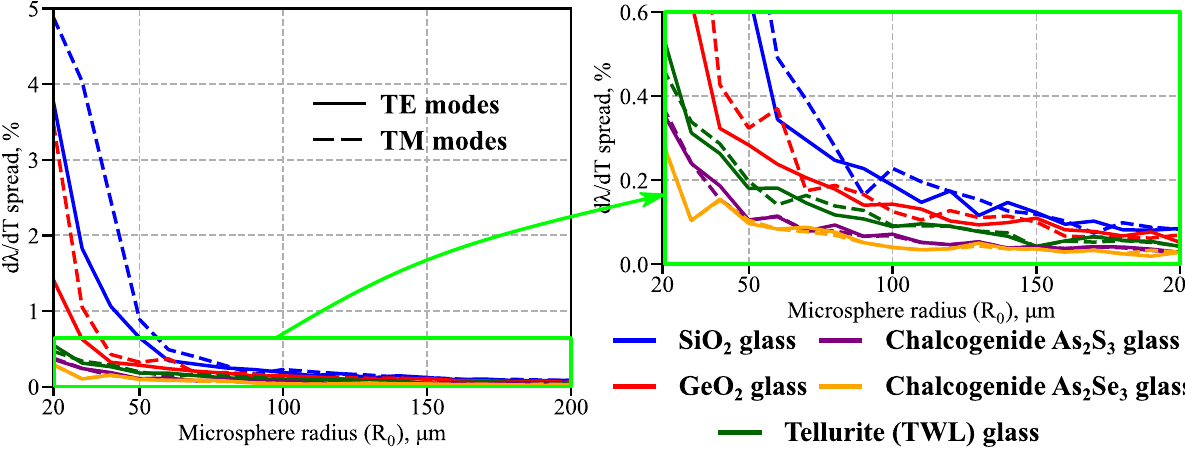
Figure 6. Calculated temperature sensitivity spread (maximum relative variation in d λ /dT ) across WGMs with radial indices 1 ≤ q ≤ 10 as a function of microsphere radius R 0 for TE (solid lines) and TM (dashed lines) polarizations. Results are shown for T = T 0 = 293 K, λ = 1.55 μ m.